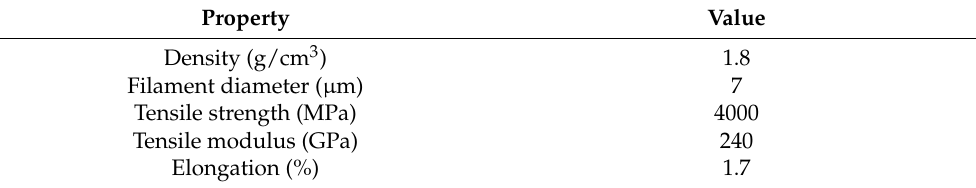
Table 1. Unidirectional carbon fiber properties.